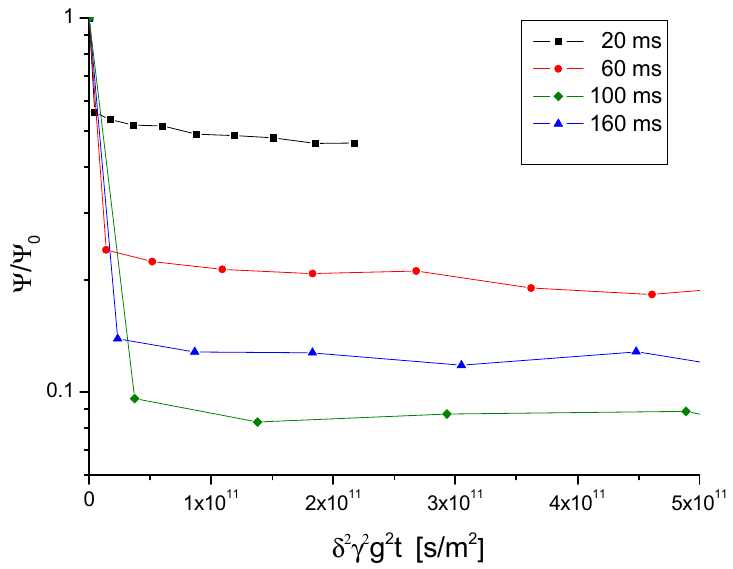
Figure 8. PFG NMR attenuation curves for propane in NaCa-LTA-2 for different observation times at 25 °C .